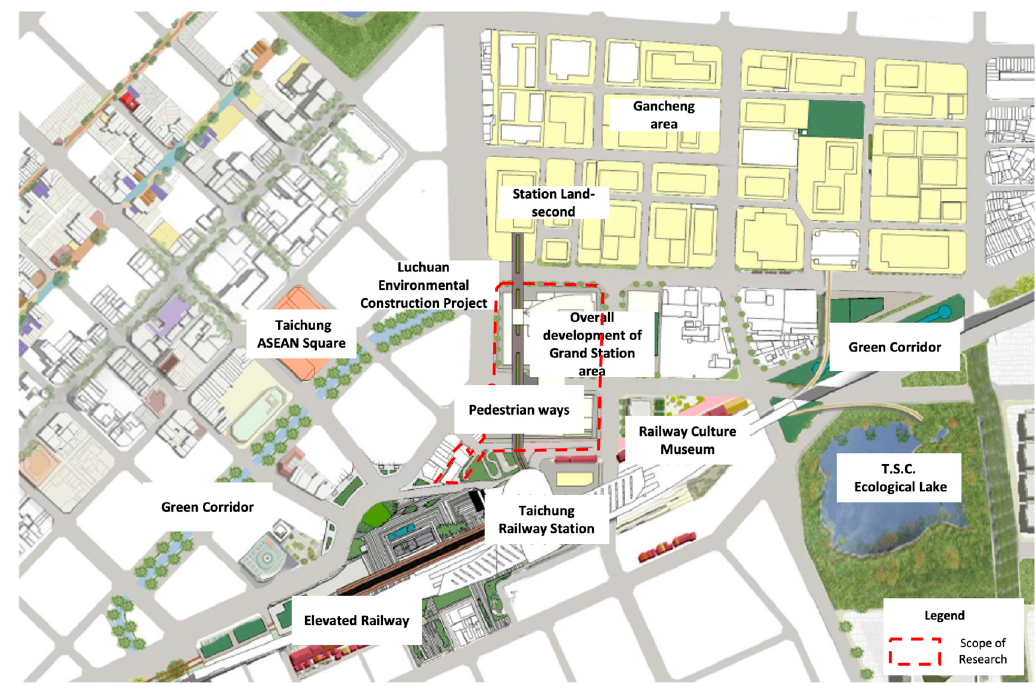
Figure 1. Vision of Taichung Grand Station. Source: Urban Development Bureau, Taichung City Government, Project Report on the Grand Station Project (2017) [38].